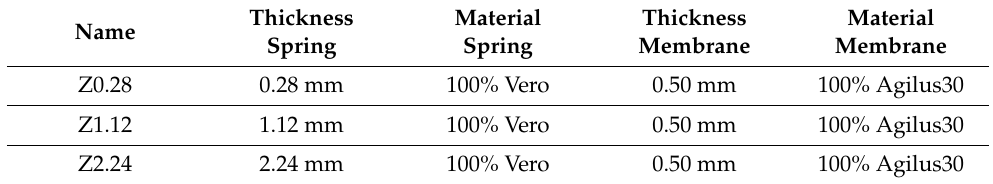
Table 3. Properties of the ortho-planar spring designs used in the second test